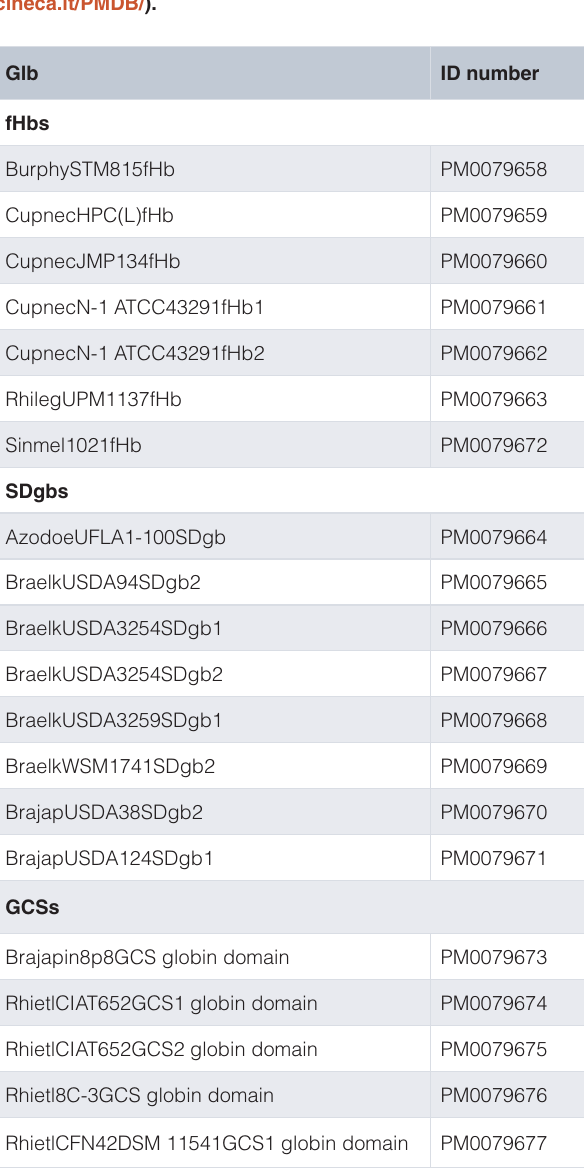
Table S2. Predicted structures of rhizobial Glbs deposited in the Caspur protein model dataBase (http://bioinformatics.